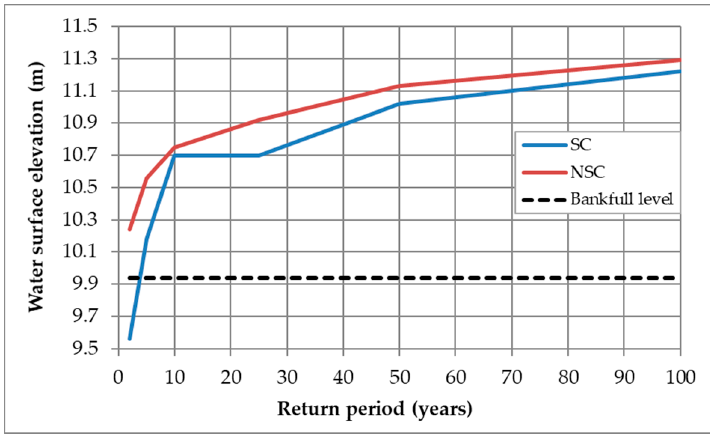
Figure 13. Water level at cross-section K0+018.5 for different return periods under stationary and non-stationary conditions.